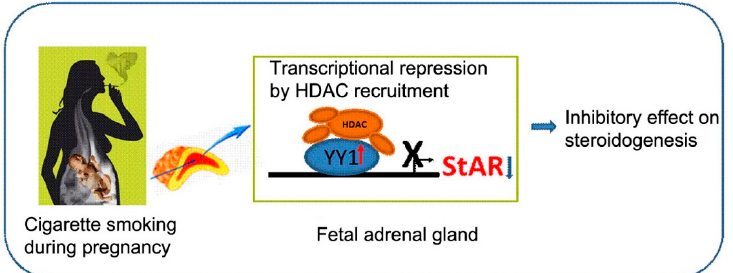
Figure 5. Proposed mechanism for the suppression of fetal adrenal steroidogenesis acute regulatory protein (StAR) expression following nicotine treatment. Nicotine treatment induced YY1 expression. Then YY1, acting as a negative transcription factor at the StAR promoter, recruited HDACs to the promoter of StAR and suppressed its transcription and steroidogenesis. YY1: Yin Yang 1; HDAC: histone deacetylases. Red arrow indicates gene expression increases and blue arrow indicates gene expression decreases.